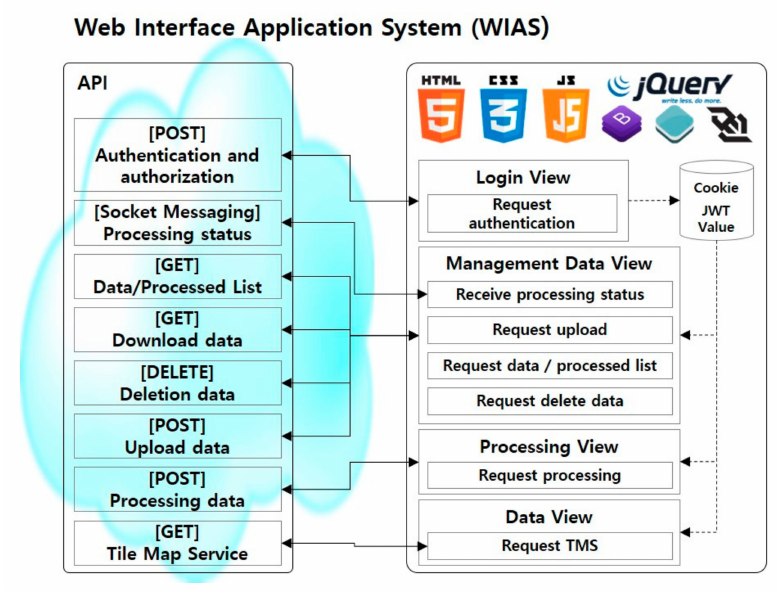
Figure 4. Features and processing modules for WIAS and Restful API with data